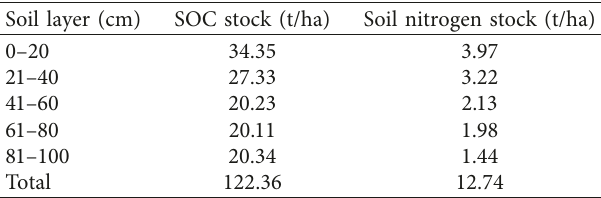
Table 2: Organic carbon and nitrogen stocks in different soil layers. Soil layer